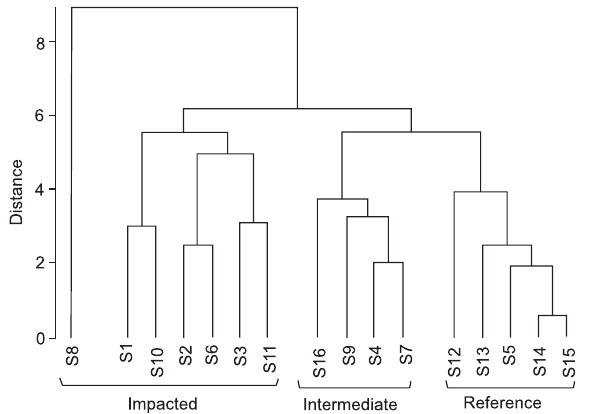
Figure 2. Stream sites grouped by their environmental characteristics by using UPGMA (Unweighted Pair Group Method with Arithmetic Mean). Height at y-axis refers to Euclidean distance. Table 1. Environmental variables (mean ± standard deviation) from reference, intermediate and impacted stream